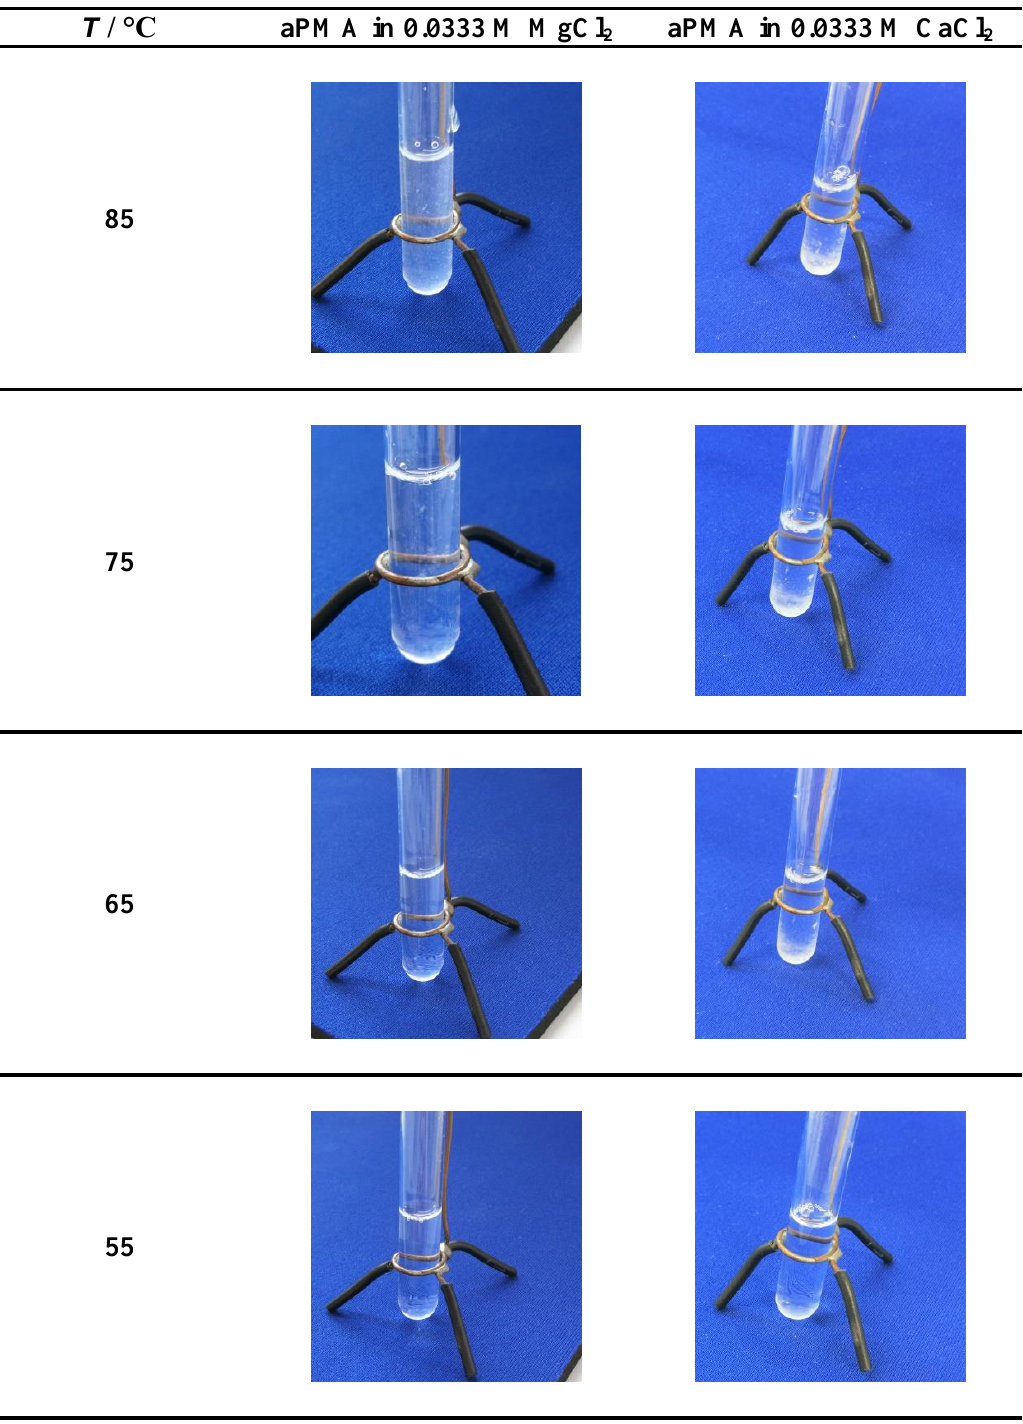
Table S3. Visual observations of aPMA ( c CaCl during cooling in a water bath. For taking photos, samples were briefly taken from the water bath and 2 photographed